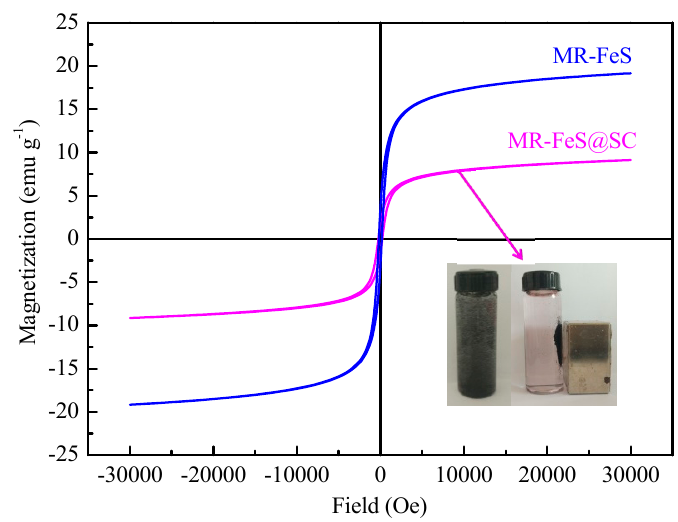
Figure 6. Hysteresis loops of MR–FeS and MR–FeS@SC (inset picture shows the separation of MR–FeS@SC from the aqueous solution by a magnet).